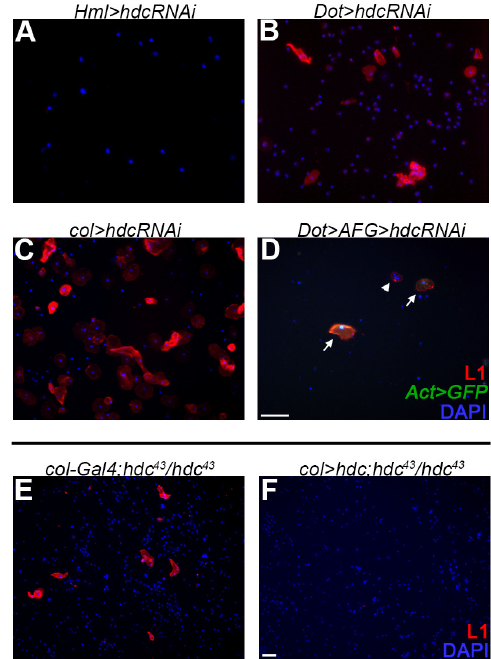
Figure 5. The effect of hdc silencing and the rescue of the hematopoietic phenotype. ( A ) Silencing hdc with the plasmatocyte specific Hml-Gal4 ( Hml ∆ -Gal4, UAS-GFP, UAS-hdcRNAi ) did not result in the differentiation of lamellocytes; ( B ) Silencing hdc with the lymph gland specific Dot-Gal4 driver ( Dot-Gal4/UAS-hdcRNAi ) resulted in the differentiation of lamellocytes (red); ( C ) Silencing hdc in the PSC of the lymph gland with the col-Gal4 driver ( Pcol85-Gal4/UAS-hdcRNAi ) led to lamellocyte differentiation (red); ( D ) Silencing of hdc in the entire Dot -lineage ( y, w, UAS-Flp; Dot-Gal4, AFG/UAS-hdcRNAi ) resulted in the appearance of lamellocytes in the circulation (red). These lamellocytes fell into two classes. The lamellocytes, which derive from the Dot -lineage, expressed both GFP (green) and the lamellocyte specific L1 antigene (red). The lineage-independent lamellocytes expressed only the L1 marker (red). Arrowhead indicates a GFP - lamellocyte, while arrows point to double positive lamellocytes; ( E – F ) Lamellocytes (red) were always present in the circulation of hdc 43 homozygous larvae ( Pcol85-Gal4/+; hdc 43 /hdc 43 ) (2.85% (n = 12)) ( E ), while their proportion was reduced when hdc was overexpressed with the col-Gal4 driver ( Pcol85-Gal4/UAS-hdc.S; hdc 43 /hdc 43 ) (0.25% (n = 12)) ( F ). Nuclei were stained with DAPI (blue). Hemocytes were visualized on a Zeiss Axioskope 2MOT epifluorescent microscope, original magnification × 20 ( A – D ) and × 10 ( E , F ) and processed with ImageJ and Adobe Photoshop CS2 softwares. Scale bars: 20 µm.